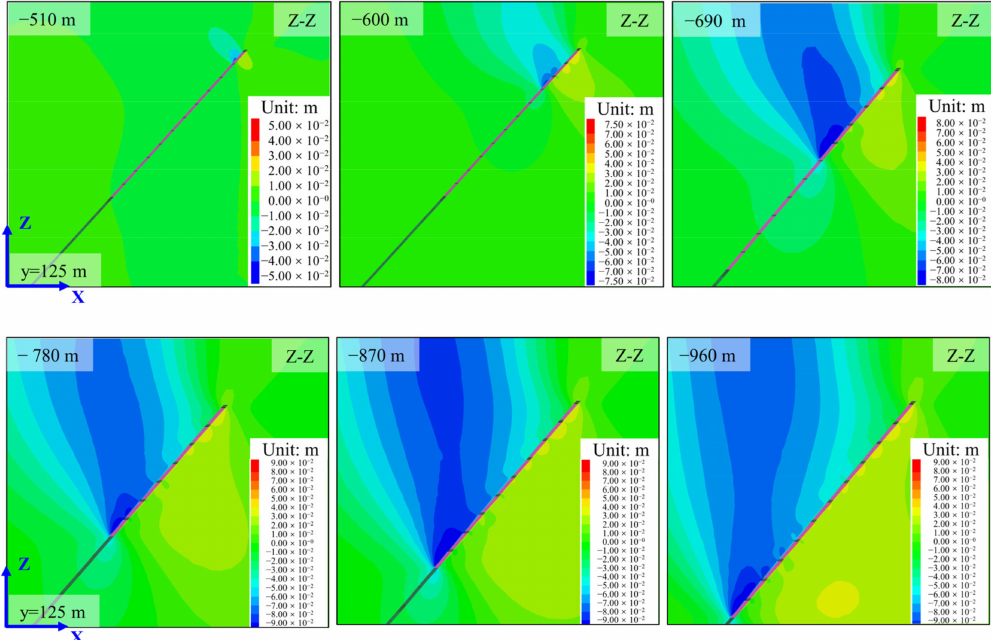
Figure 5. Vertical displacement of ground at different depths of